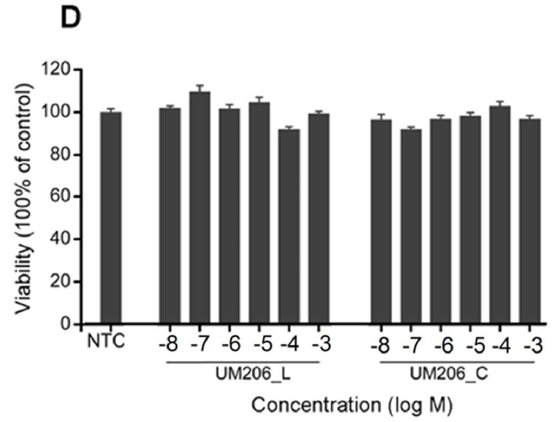
Figure 4. Dose response of UM206 functionalized MNPs on TCF/LEF signaling induction in HEK293 Luc-TCF/LEF cells. ( A ) Left and right: the starting ratio of peptide-to-MNP is 10 μg-per-mg MNP and 1 μg-per-mg MNP, respectively. ( B ) Effects of control MNPs without conjugation. ( C ) Viability of HEK293 cells in response to various treatments and ( D ) to indicated concentration of peptides. “Loading” indicates MFB exposure, and “Static” indicates no exposure to MFBs. In ( A , B ), luminescence was defined as fold change with respect to the non-treated control (NTC) group. For ( A – D ), data are presented as mean ± SEM, n = 4 and shown here is a representative set of results of two independent experiments (* p <